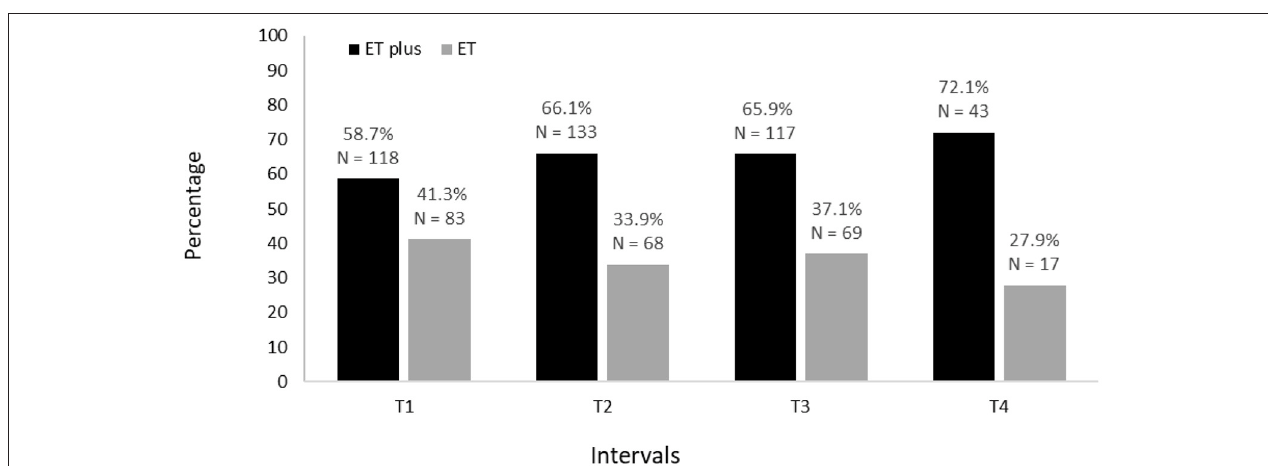
FIGURE 2 | Prevalence of ET vs. ET plus from baseline (T1) to 54 months after baseline